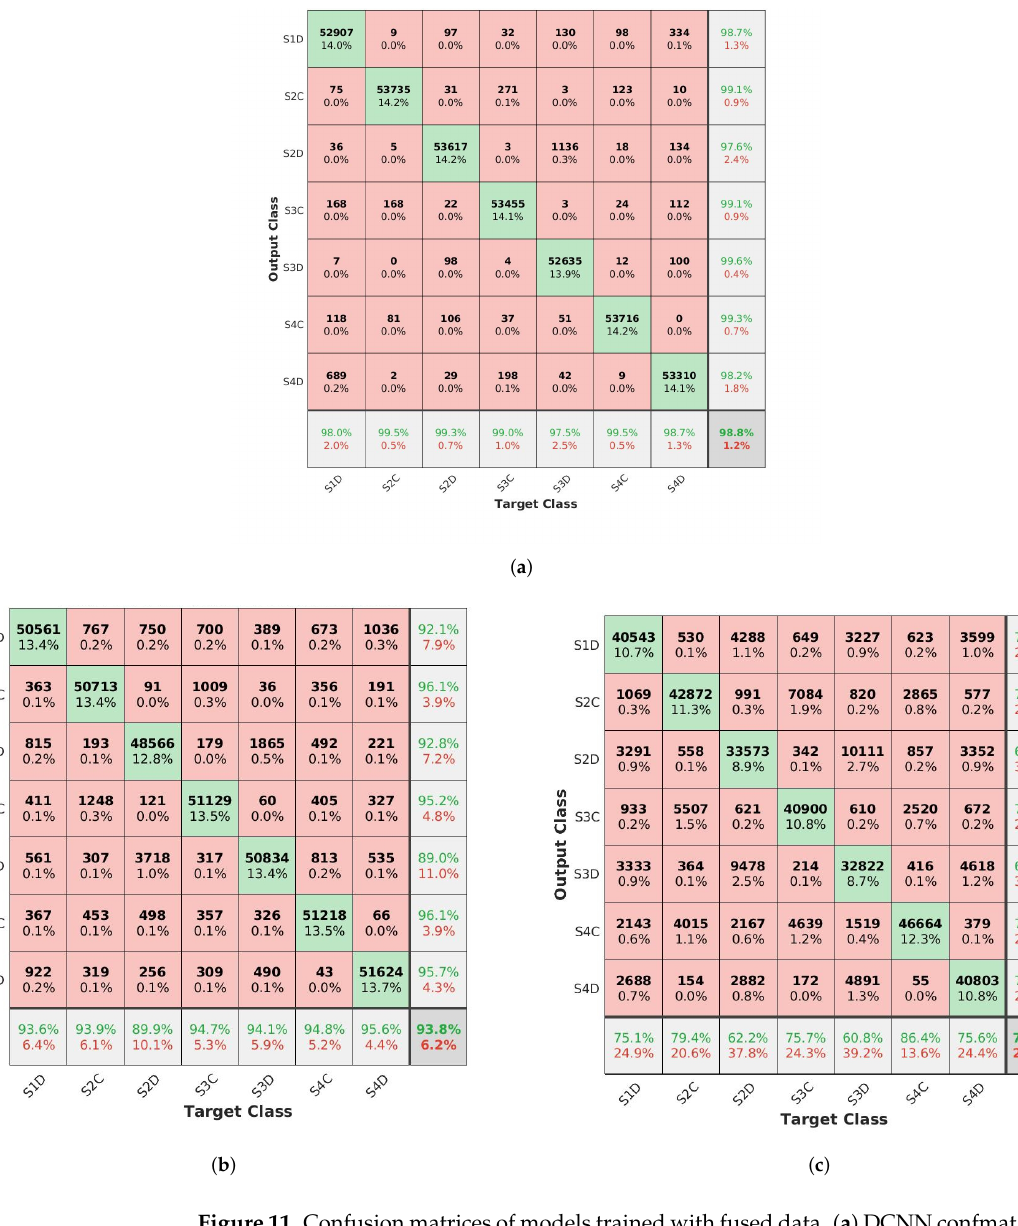
Figure 11. Confusion matrices of models trained with fused data. ( a ) DCNN confmat. ( b ) CNN-LSTM confmat ( c ) LSTM